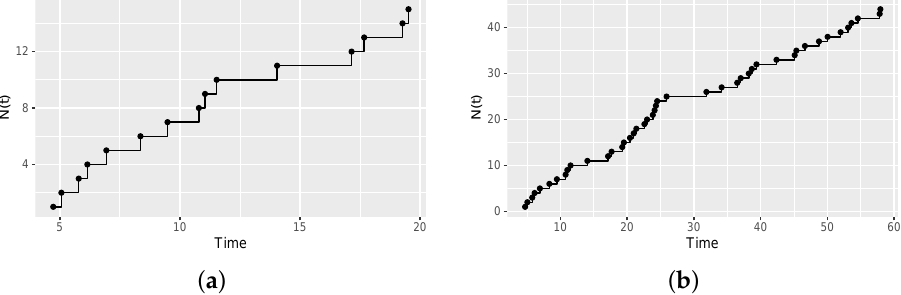
Figure 6. Simulation of a Cox process with Folded Normal intensity function of parameters µ = 5, σ 2 = 8 and with covariance function k Z ( h ) = 9 · I { 0 } ( h ) for T = 20 ( a ) and T = 60 ( b ).